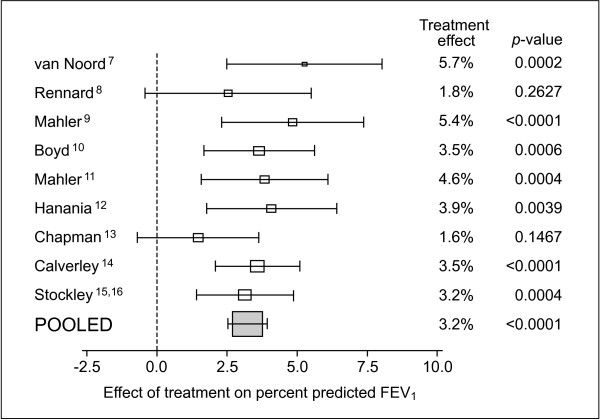
Percent predicted FEV1 (Intent To Treat population).